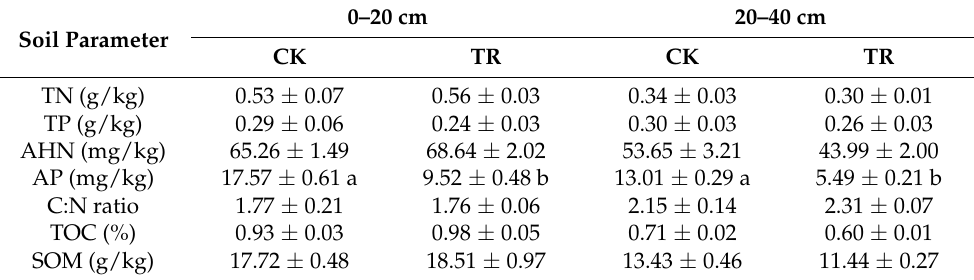
Table 1. Values of soil chemical properties in TR and CK plots in different soil depths. 0–20 cm 20–40 cm Soil Parameter CK TR CK TR TN (g/kg) 0.53 ± 0.07 0.56 ± 0.03 0.34 ± 0.03 0.30 ± 0.01 TP (g/kg) 0.29 ± 0.06 0.24 ± 0.03 0.30 ± 0.03 0.26 ± 0.03 AHN (mg/kg) 65.26 ±